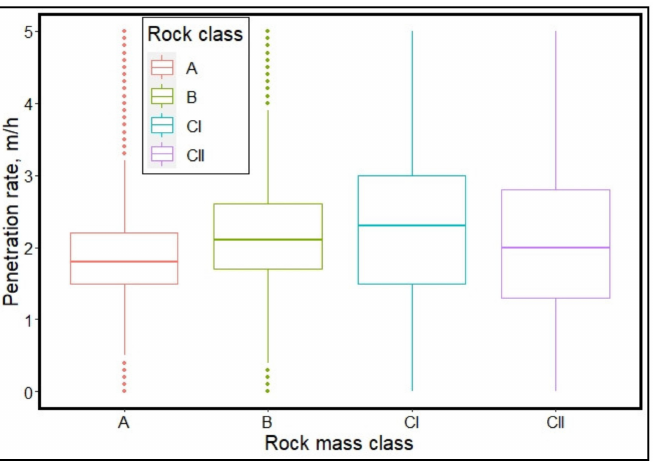
Figure 7. Distribution of TBM penetration rate in different rock mass classes.